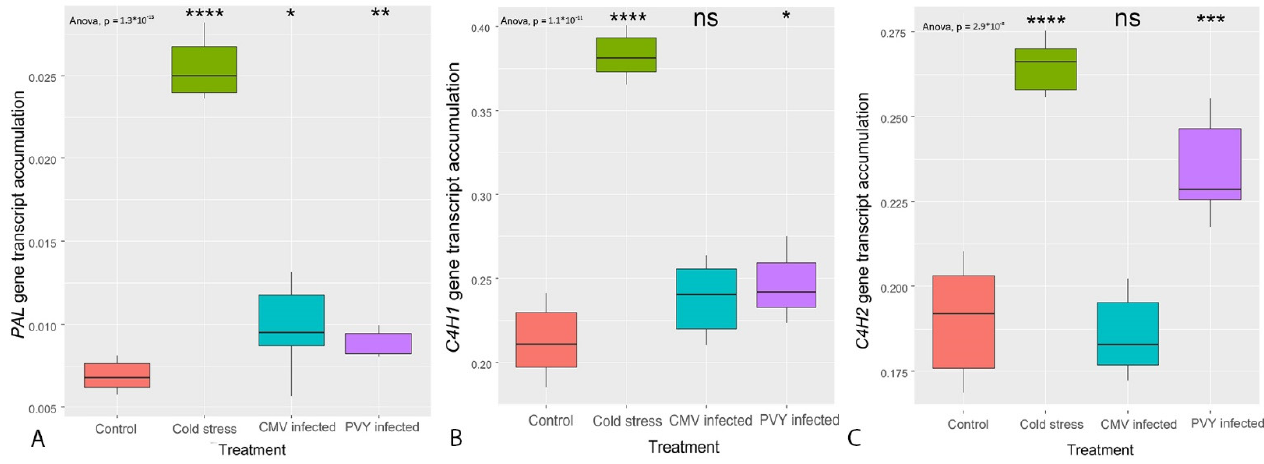
Figure 3. Transcription of the genes encoding for phenylalanine ammonia-lyase (PAL) ( A ), and cinnamic acid 4-hydroxylase (C4H1, C4H2) ( B and C , respectively) enzymes of tomato leaves (cv. Elpida) following plant exposure to cold stress (5 °C for 16 h) or inoculation (20 d) with either cucumber mosaic virus (CMV) or potato virus Y (PVY). Significant differences were determined by one-way ANOVA comparisons ( p ≤ 5%). Signif. codes: ns: non-significant; 0.05: *; 0.01: **; 0.001: ***; 0: ****.